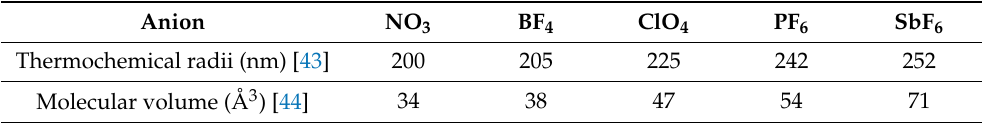
Table 3. Thermochemical radii and volume of anions used for the preparation of CPs. Anion NO 3 BF 4 ClO 4 PF 6 SbF 6 Thermochemical radii (nm) [43] 200 205 225 242 252 Molecular volume (Å 3 ) [44] 34 38 47 54